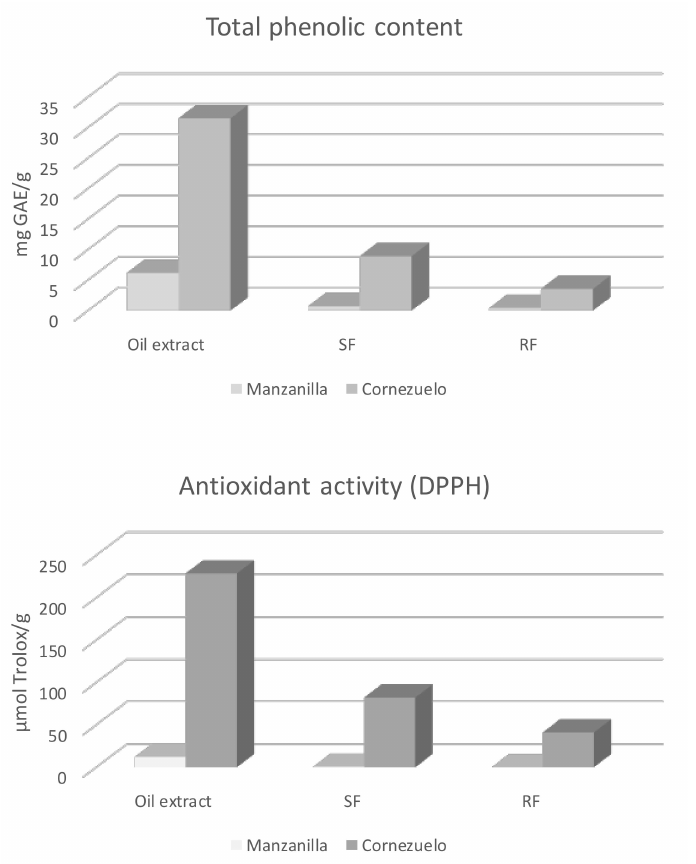
Figure 4. Total phenolic contents (TPC) and antioxidant capacities (AC) of Manzanilla and Cornezuelo table olive extracts (before SGD), SF (soluble fractions after SGF; liquid), and RF (residual